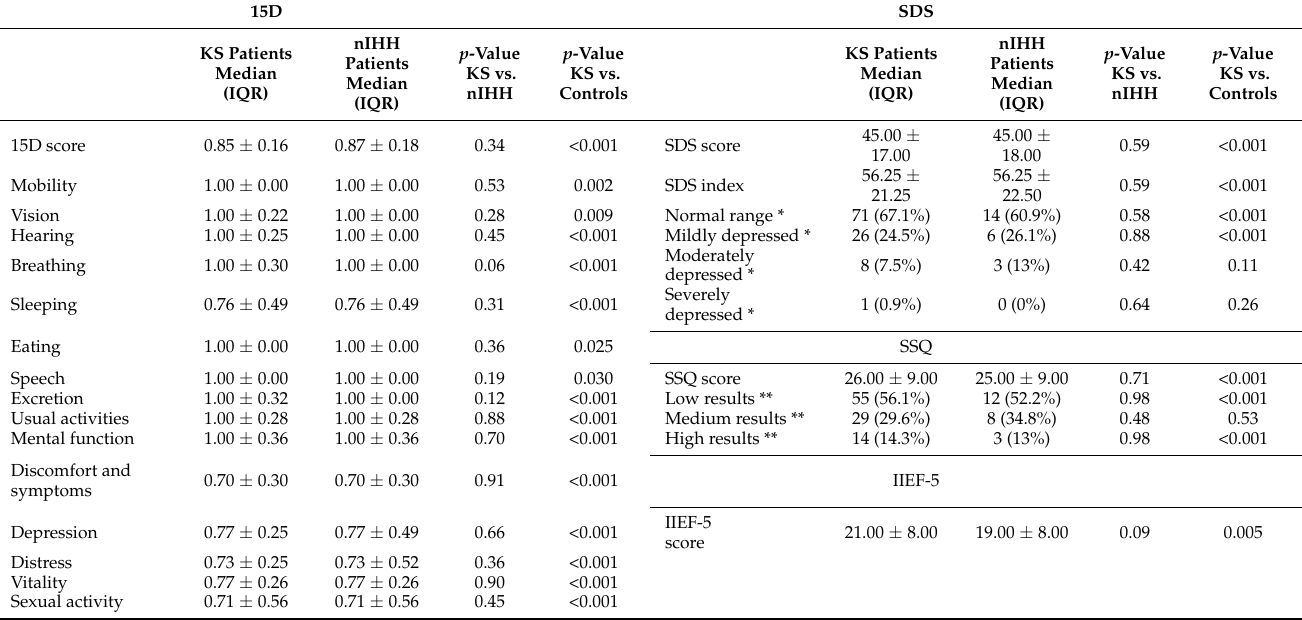
Table 3. Scores from the 15D instrument (15D), the Zung Self-Rating Depression Scale (SDS), the Sexual Satisfaction Questionnaire (SSQ), and the 5-item International Index of Erectile Function (IIEF-5)—data from Kallmann syndrome (KS) and normosmic IHH (nIHH)